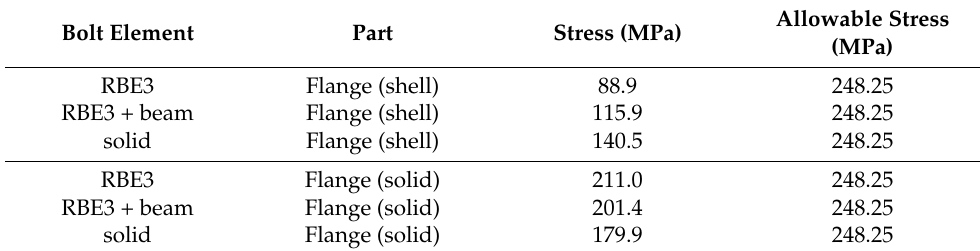
Table 16. Maximum equivalent stresses of the flange.